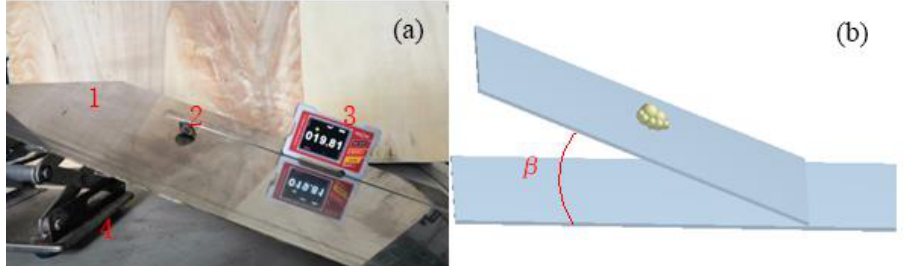
Figure 2. Static friction coefficient calibration test: ( a ) direct measurement: 1 Wall; 2 Clam; 3 Inclinometer; 4 Lifting platform ( b ) DEM simulation test.